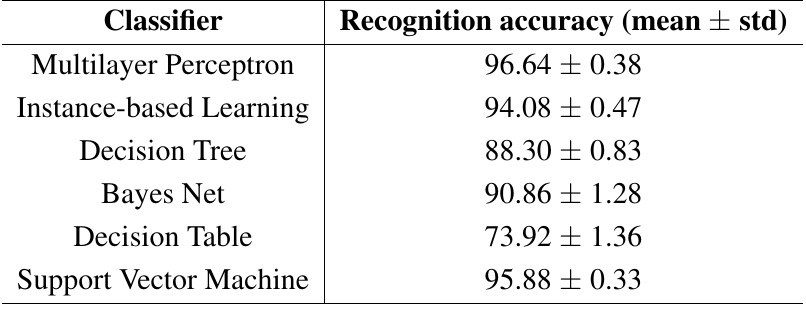
Table 7. Summary of classifier results (mean ± standard deviation). Comparison of recognition accuracy (%) of user identification by walking pattern.